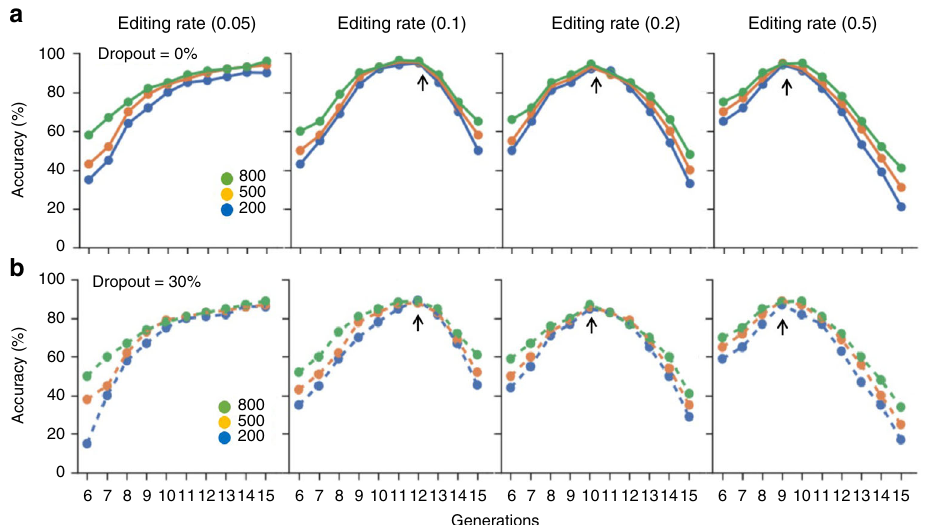
Fig. 3 Performance simulations of the targeted deaminase system. Continued editing was allowed until G generations (see Methods for detail). After that, the accuracy (y-axis) was calculated as the percentage of correct order of pairwise relationships between the edits generated within G generations (see Methods). We compared the effect of dropouts on accuracy. a No dropout shown by solid lines and ( b ) dropout applied shown by dashed lines. The in fl ection point is indicated by the black arrow. Different colors correspond to different numbers of target sites and the units for the editing rate (base substitution rate) are mutations/site/cell division. The source data are available in the Source Data fi